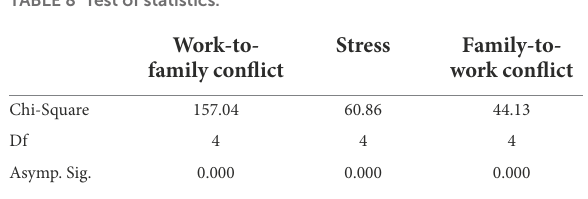
a. Kruskal Wallis Test b. Grouping Variable: